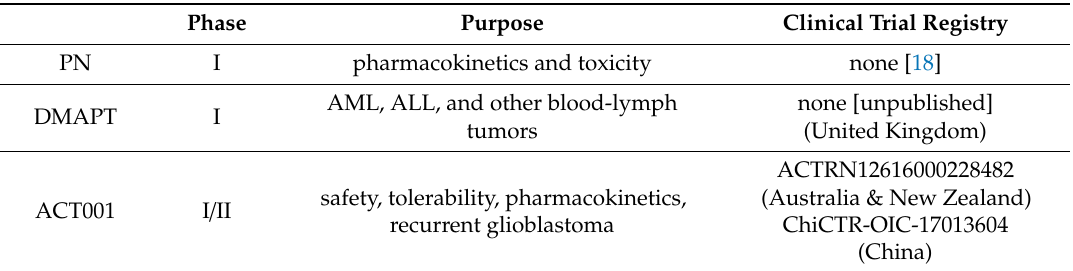
Table 2. Clinical evaluation of activity of PN and its